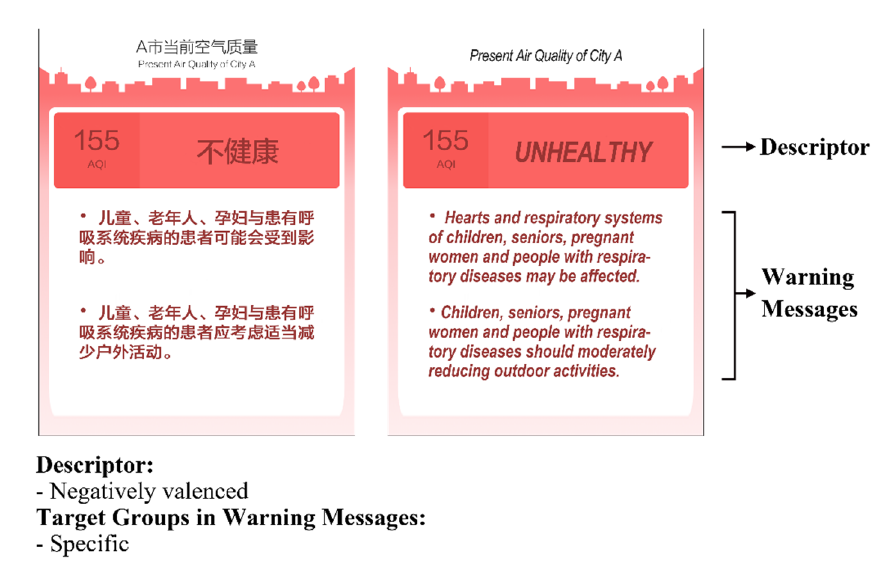
Figure 1. The layout of the experimental stimuli.